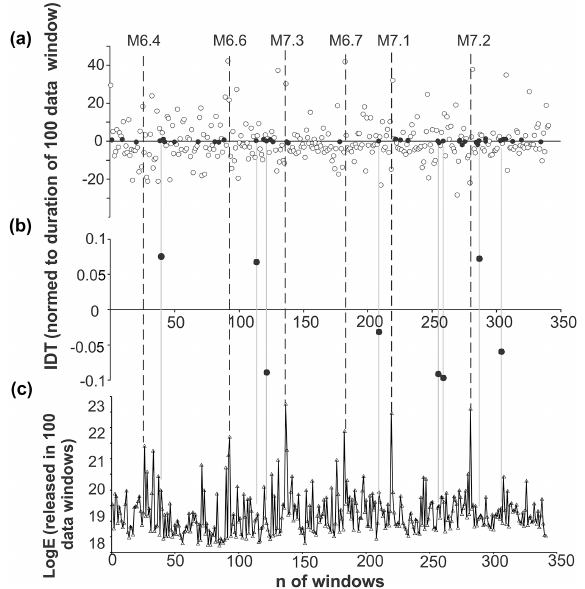
Figure 12. Calculated for the non-overlapping 100 data windows (shifted by 100 data), integral deviation times (IDTs) (circles in pan- els a and b ) and the released seismic energies (c) . IDT values in the vicinity of 0 . 1 σ from zero are given by black circles in panel (a) . IDT values in the vicinity of 0 . 01 σ from zero are given by black circles in the middle figure. By grey lines we show the location of closest to zero IDT values relative to the released seismic en- ergy. Dashed lines show the occurrence of largest earthquakes in the southern California catalog (above threshold M = 2 .